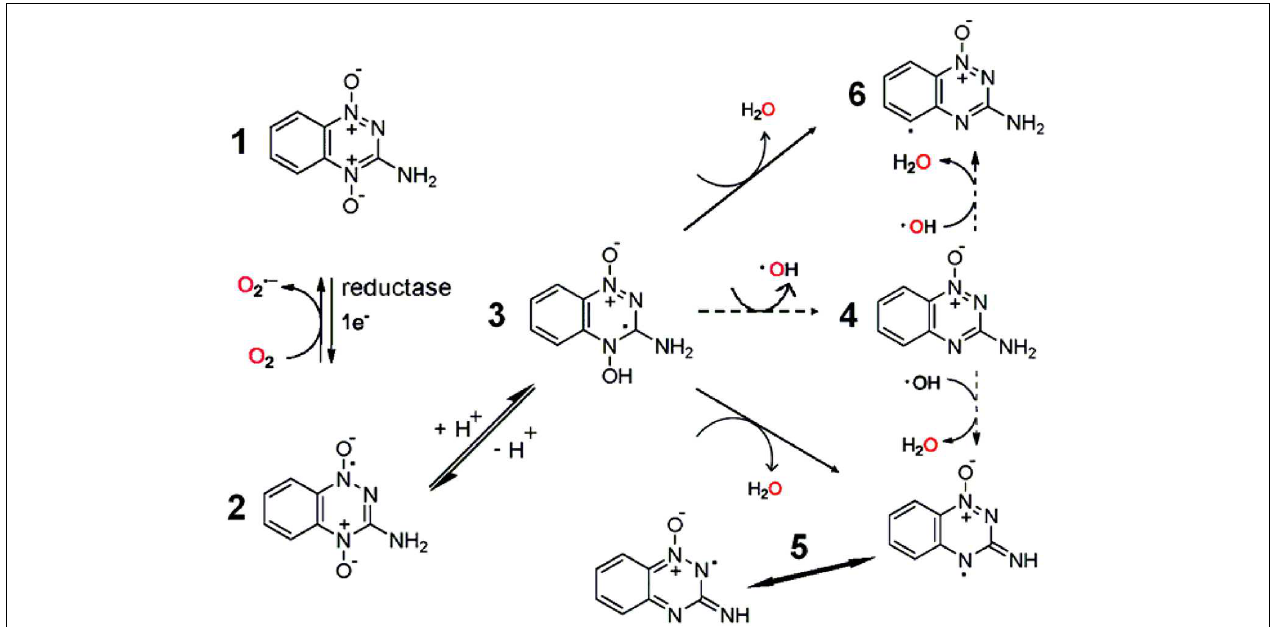
FIGURE 7 | Bioreduction of TPZ with produced free radicals based on Shinde et al. (2010) and Yin et al. (2012).